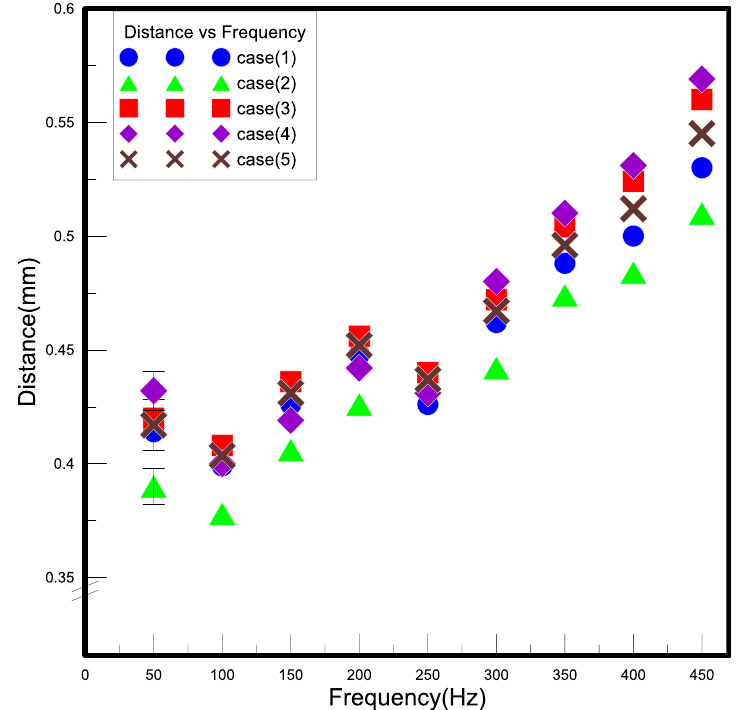
Figure 10. The results of displacement measurement.